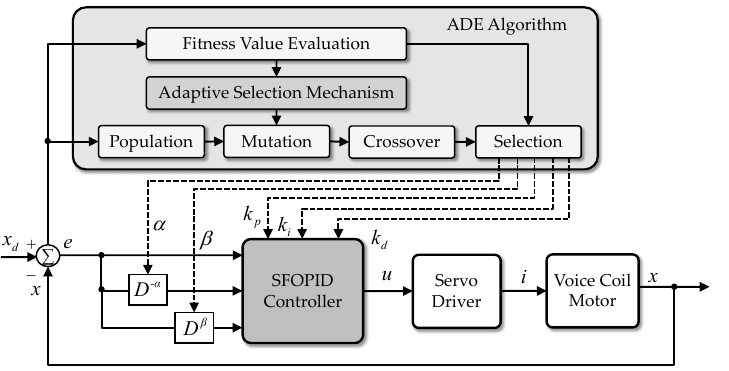
Figure 4. Control diagram of the VCM control system using the proposed self-tuning FOPID (SFOPID) controller with adaptive differential evolution (ADE) algorithm.